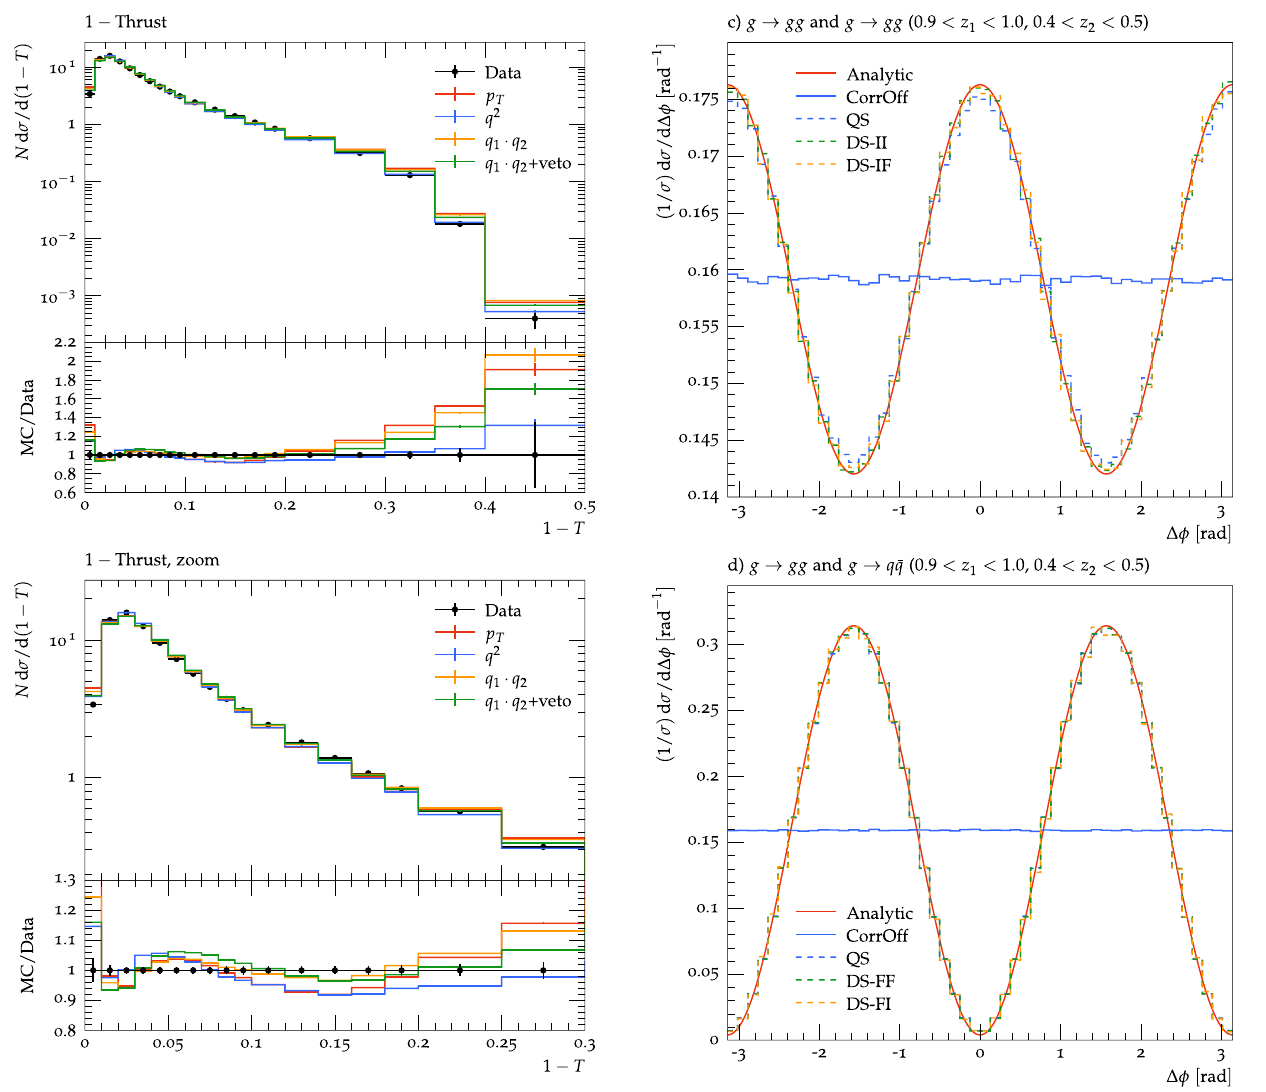
Fig. 3 Examples of the spin correlations in the parton shower for g → gg with subsequent g → gg and g → q ¯ q branching. For details, see Ref.